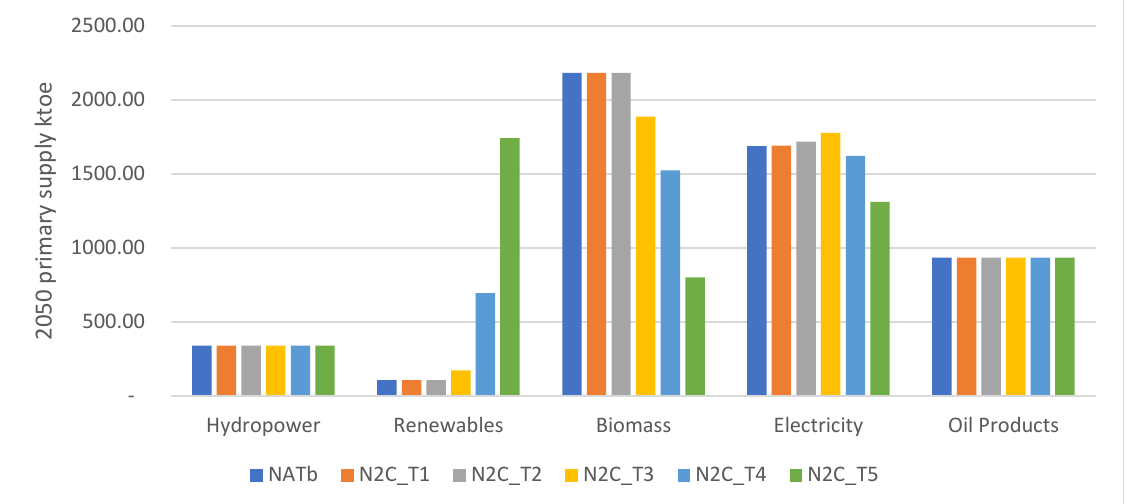
Figure 7. Energy supply by 2050 for scenarios based on NATb. While the results obtained with LEAP do not represent a timeline of events to reach rural electrification by 2050, it presents the picture of a possible future. For the QGIS results, three timestamps were used: 2030, 2040, and 2050. These timestamps can be seen in Error! Reference source not found. for 2030, Error! Reference source not found. for 2040, and Error! Reference source not found. for 2050. As the meth- odology describes, each colored spot on the map is a hexagonal geographical unit of 5 km of internal diameter. Each colored unit represents which tier of electrification is both via- ble and affordable for the geographical unit.